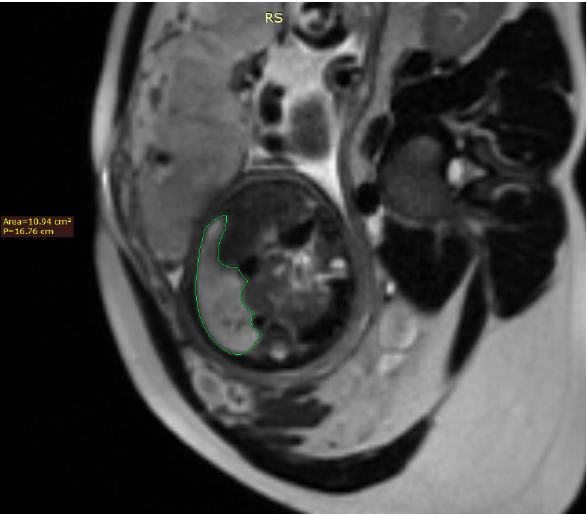
Figure 1. Axial image of the fetus showing the tracing method for calculating the lung volume, using the RadiAnt DICOM Viewer